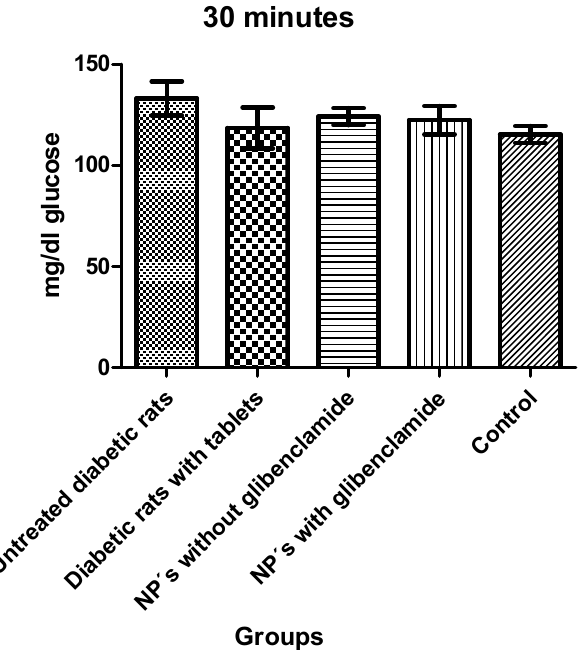
Figure 17. Glucose levels 30 min after administration of a glucose solution and glibenclamide treatments.